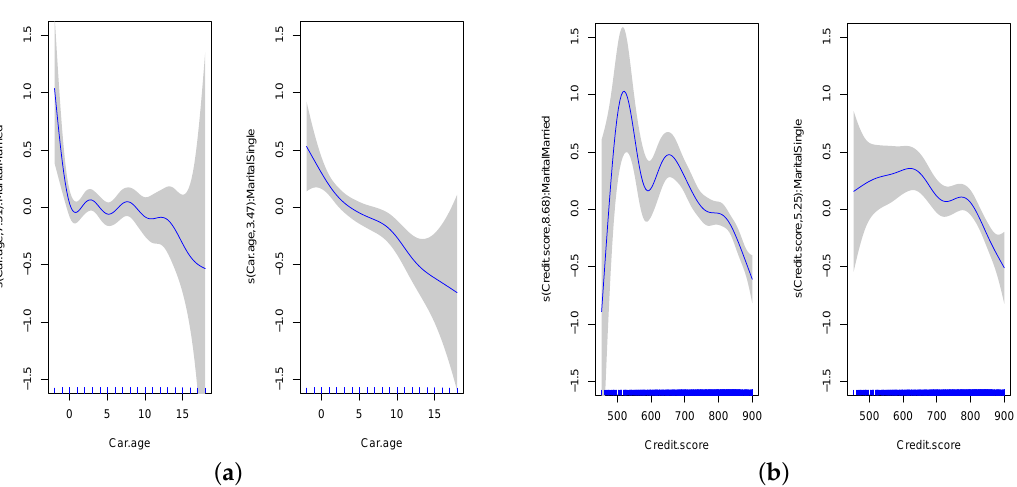
Figure 10. The plots of fitted spline functions for Car Age and Credit Scores, separated by Marital Status. ( a ) Car Age by Marital Status; ( b ) Credit Scores by Marital Status.